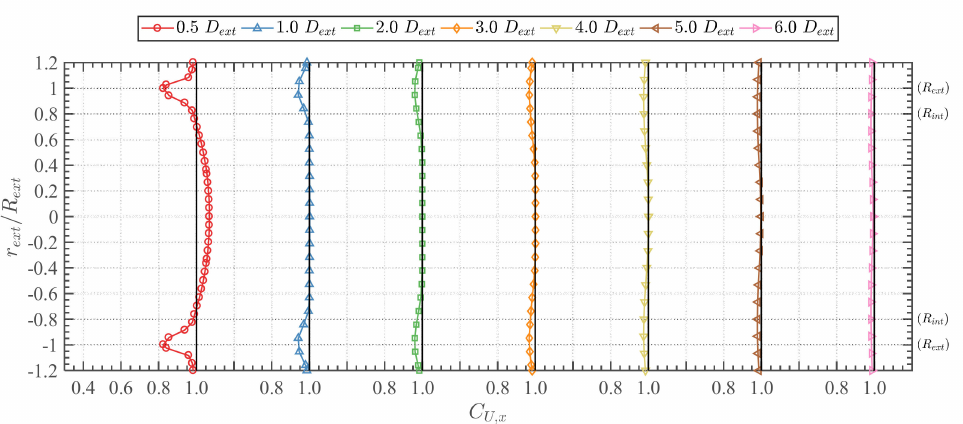
Figure 9. Axial velocity coefficient ( C U , x ) profiles within the duct wake at different downstream displacements ( U ∞ = 4 m.s − 1 ; γ = 0 ◦